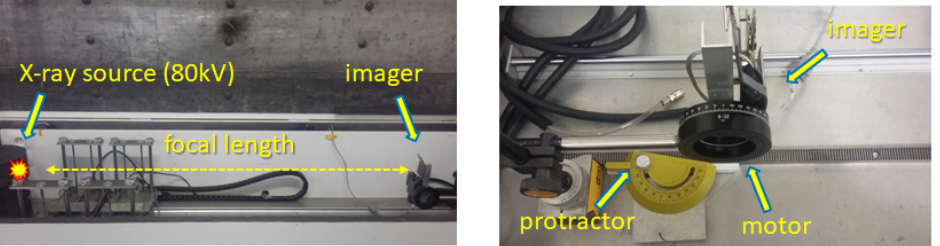
Figure 6. Experimental set up for detection and imaging of collimated X-ray and FOV measurement. The X-ray source is a micro-focus unit at Advacam. The detector and optical-collimated device are mounted on movable stepper